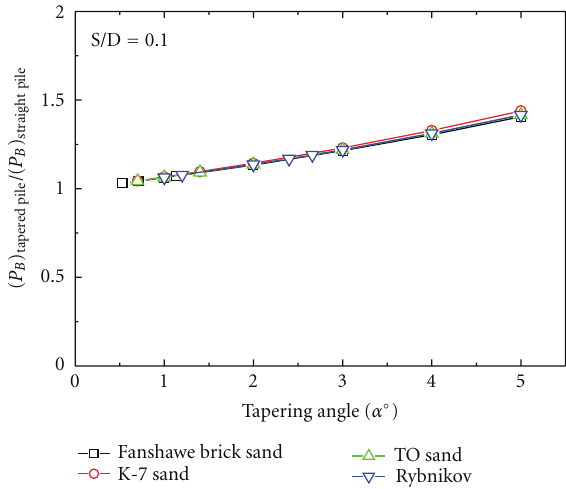
Figure 10: E ff ect of tapering angle on normalized end-bearing capacity at 0.1 settlement